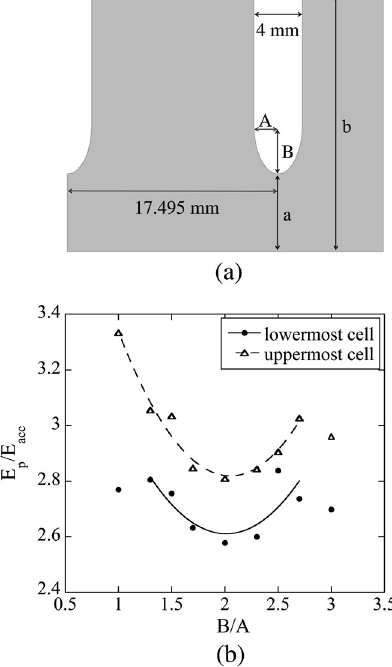
FIG. 2. (a) Cross-sectional view of the ellipsoidal curved iris. (b) Simulation result of the maximum surface electrical field over E =E depending on the ratio of B=A . The circle and triangle p acc markers show the ratios at the uppermost (n ¼ 1 ) and lowermost (n ¼ 100 ) cell cases, respectively. The solid curve is the quadratic regression curve excluding the points of B = A ¼ 1 . 0 , 3.0, and the dashed curve is the quadratic regression curve excluding the point of B = A ¼ 3 . 0 .